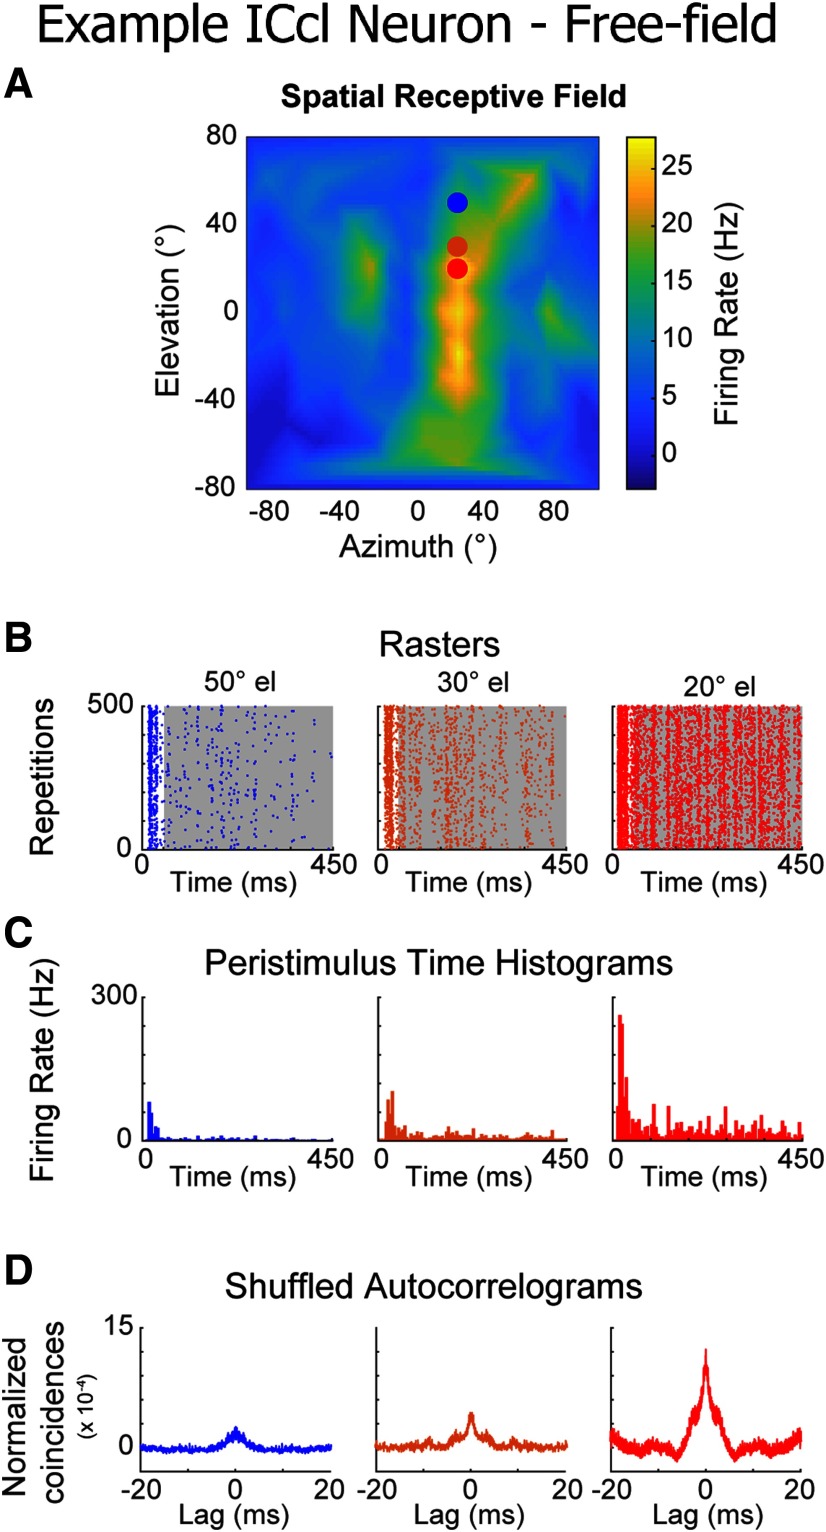
Reproducibility in ICcl to sounds from varying positions in auditory space. A, Example SpRF for an ICcl neuron. Colored dots indicate responses displayed in B–D. B, Spiking raster plots at varying elevations, from the example cell shown in A. Gray background represents region of stimulation used for SAC and distance analysis (50-ms onset responses not considered in the analysis). C, Peristimulus time histograms generated from the raster plots in B (5-ms bin size). D, SACs generated from the rasters in B.